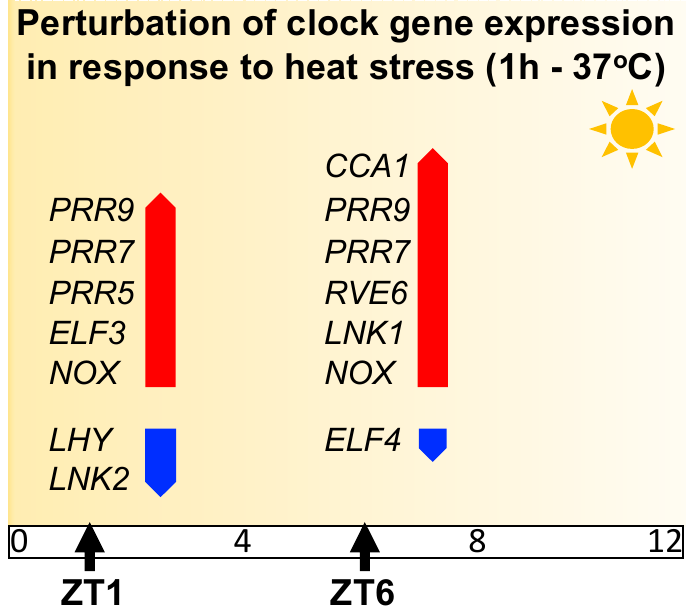
Figure 2. Impact of heat stress (37 °C) on transcript abundance of Arabidopsis clock components at two different times of the day (morning (ZT1) or afternoon (ZT6)). Upregulation (red arrow) and downregulation (blue arrow) are based on log2 fold change values obtained from RNA-seq analysis [50]. Only genes with statistically significant (FDR < 0.05) differences are represented.